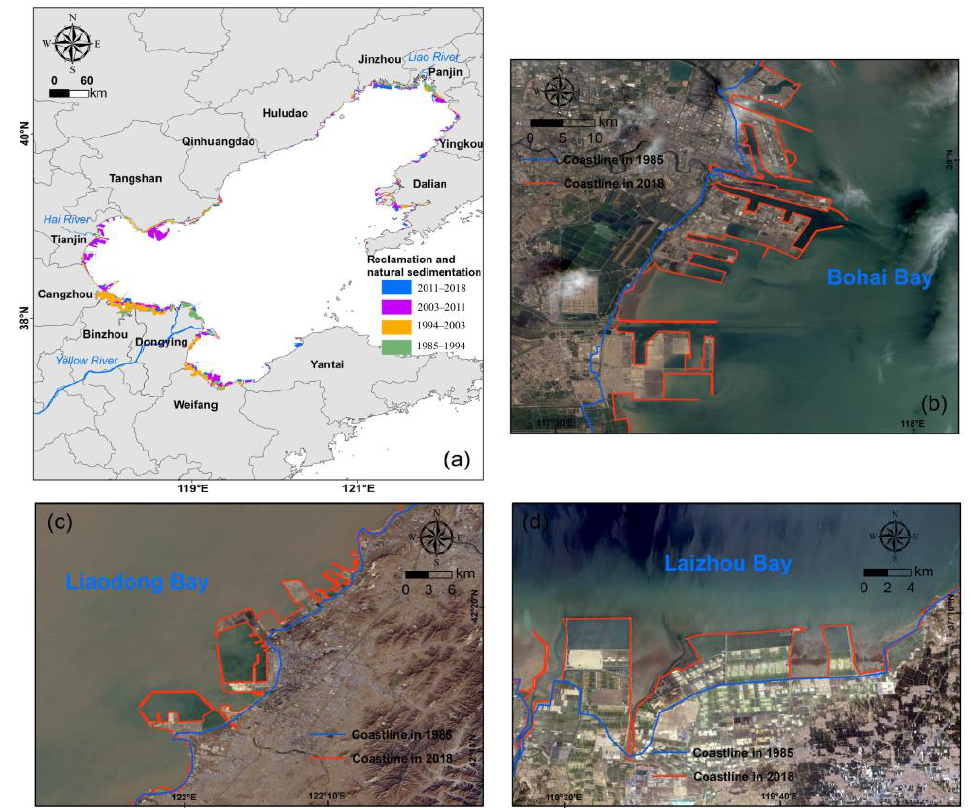
Figure 5. The BHS’s reclamation ( a ). Natural sedimentation mainly occurred on the estuary of the Yellow River, Liao River, etc. Rivers carry a large amount of sediment to form sedimentation zones at the estuary, and the land extends to the sea. the area of sedimentary bodies in the Yellow River was 250.4 km 2 from 1985 to 2018, with an average annual rate of 7.36 km 2 /yr, and that in the Liao River was 80.1 km 2 , with an average annual rate of 2.35 km 2 /yr. Artificial reclamation was widely distributed along the whole coastline of the BHS and was mainly caused by human activities, including a coastal industrial and urban area involving a large coastal reclamation project, that is, the new Tianjin coastal area ( b ); a large breeding pond on the south side of Laizhou Bay ( c ); and Yingkou Port ( d ), part of the substantial development around the